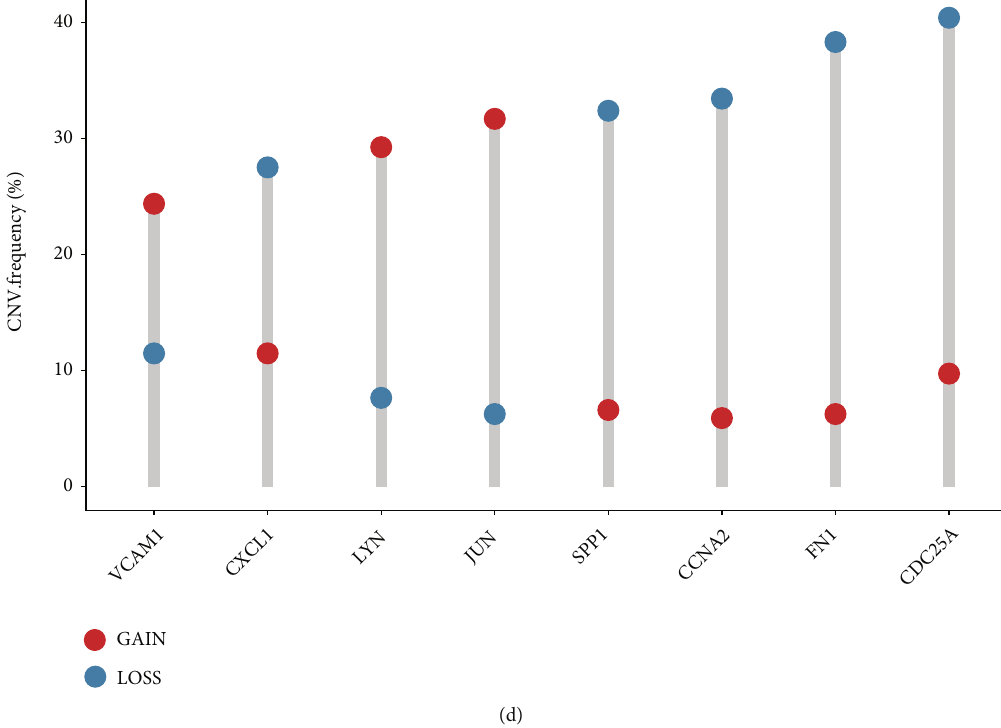
Figure 10: Landscape of eight prognostic ARGs. (a) Frequency of gene mutation and CNV in patients with two kinds of cancer. (b) Mutation and CNV of each prognostic ARG. (c) Waterfall chart of somatic mutations of ARGs. (d) Frequencies of gain and loss for eight